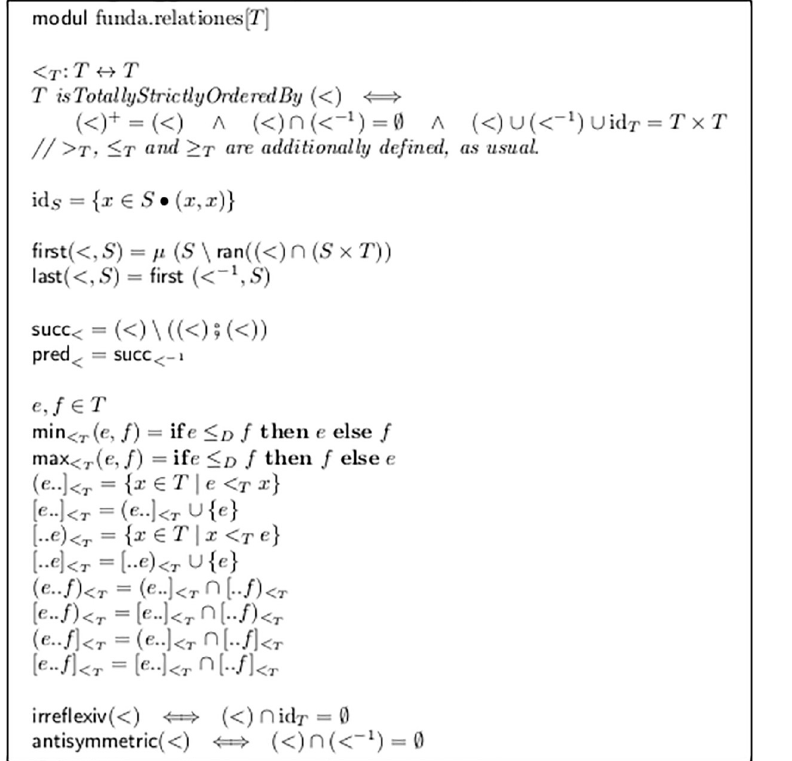
Fig 3. Basic notions about